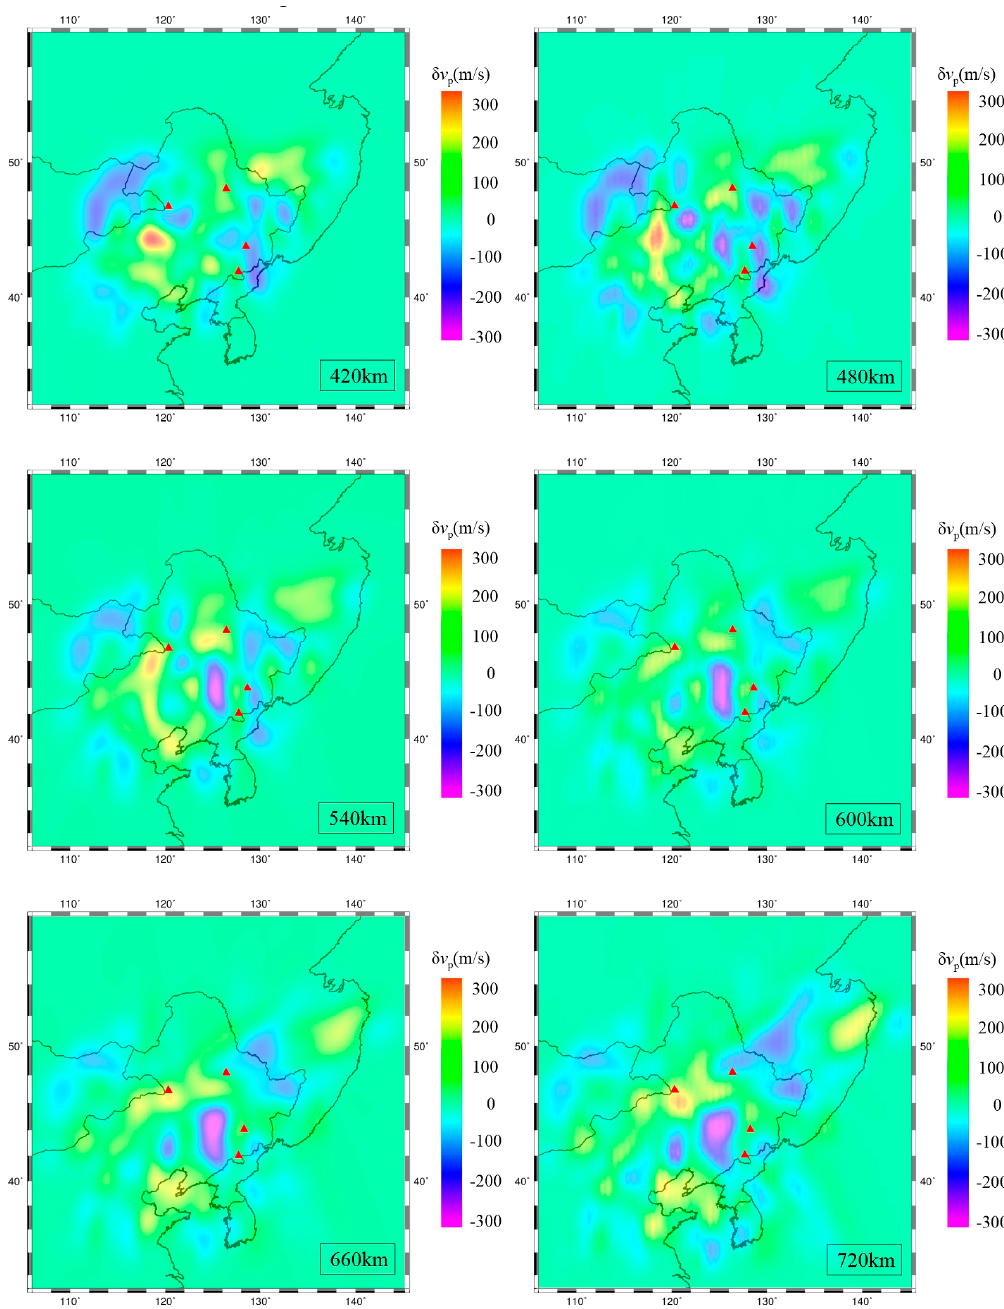
Figure 10. Horizontal section of P-wave velocity disturbance in the upper mantle of the study area (420–720 km). (420–720